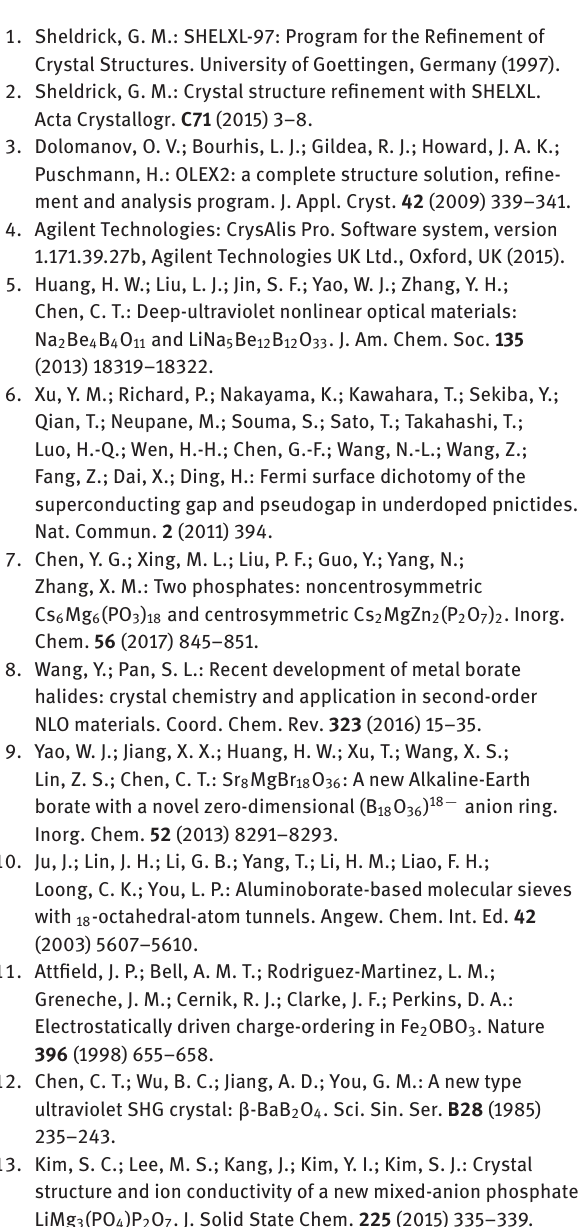
Table 2: Fractional atomic coordinates and isotropic or equivalent isotropic displacement parameters (Å 2